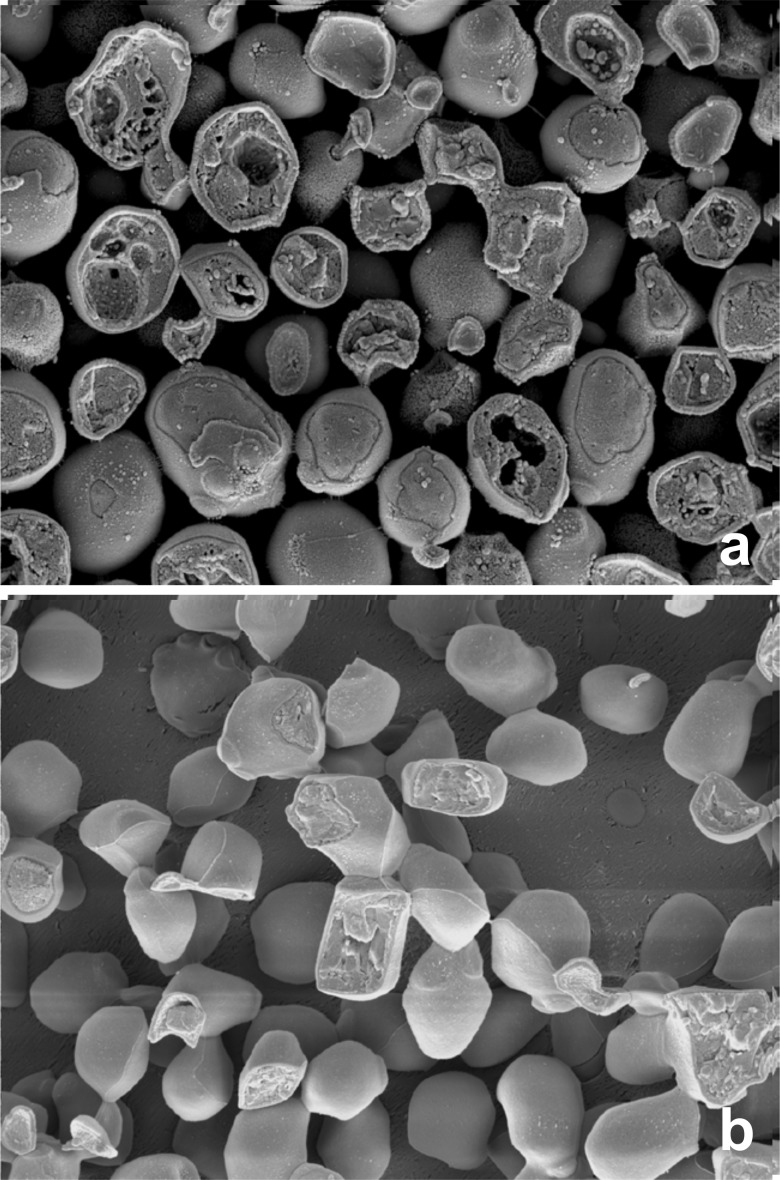
CryoSEM of S. cerevisiae 338 cells following cooling.(a) At 50°C.min-1 and (b) at 2°C.min-1. Note the large voids in cells cooled at 50°C.min1, caused by the formation of intracellular ice.